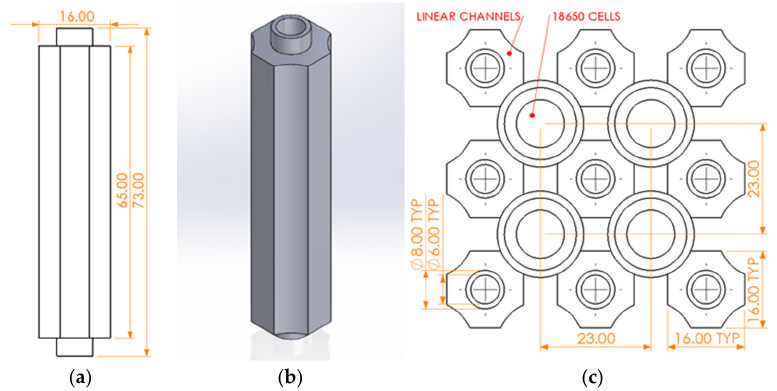
Figure 3. LCD views and dimensions, all in millimetres: ( a ) Single channel side view; ( b ) Single channel ISO view; ( c ) Battery pack top view with fluid domain removed.